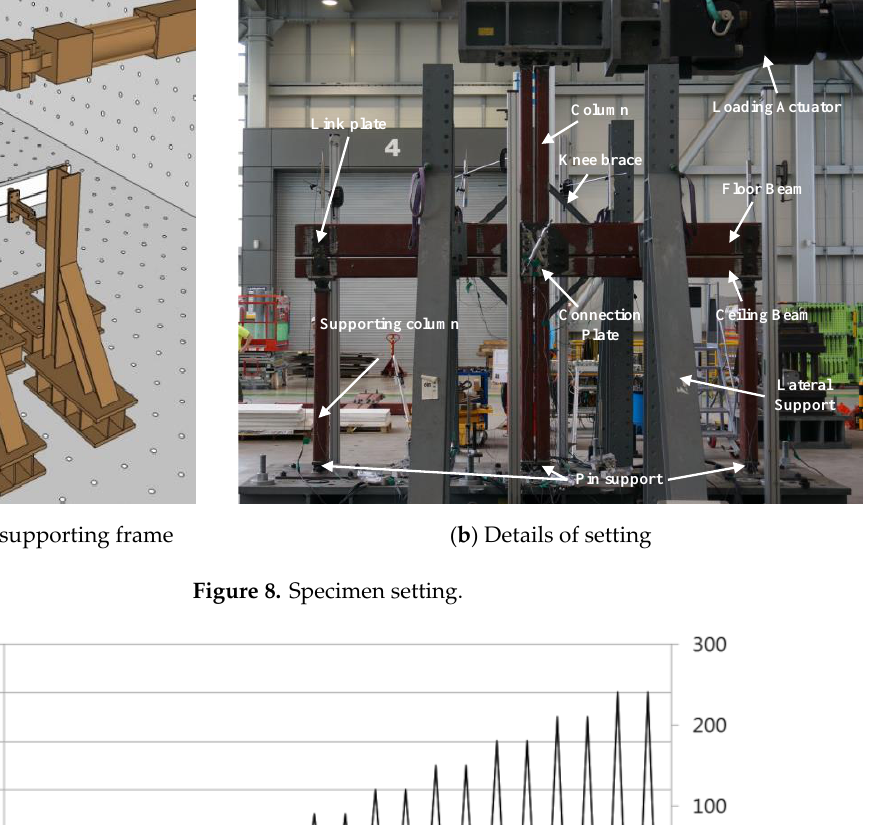
Figure 9. Cyclic loading applied to the specimens.